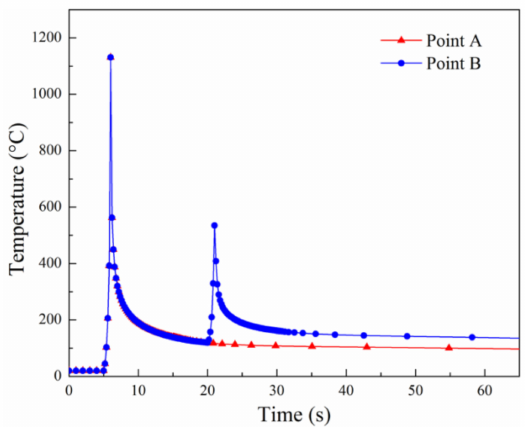
Figure 11. Weld thermal cycle curves of points A and